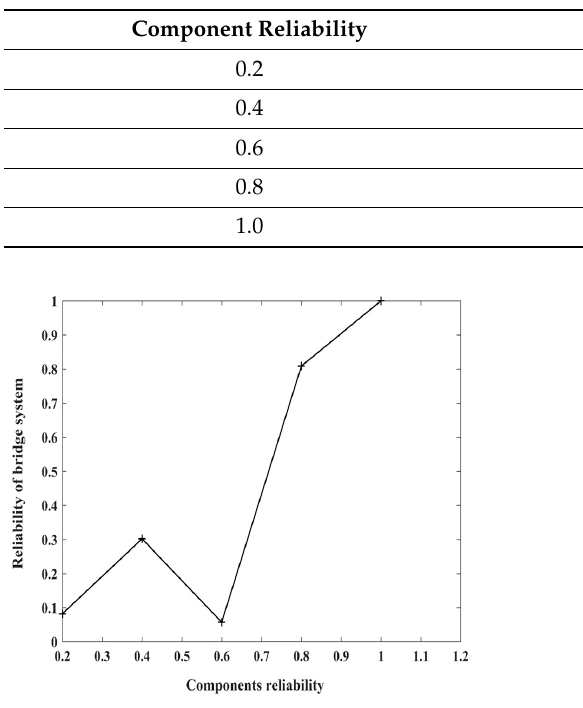
Table 1. The values of reliability of bridge system.